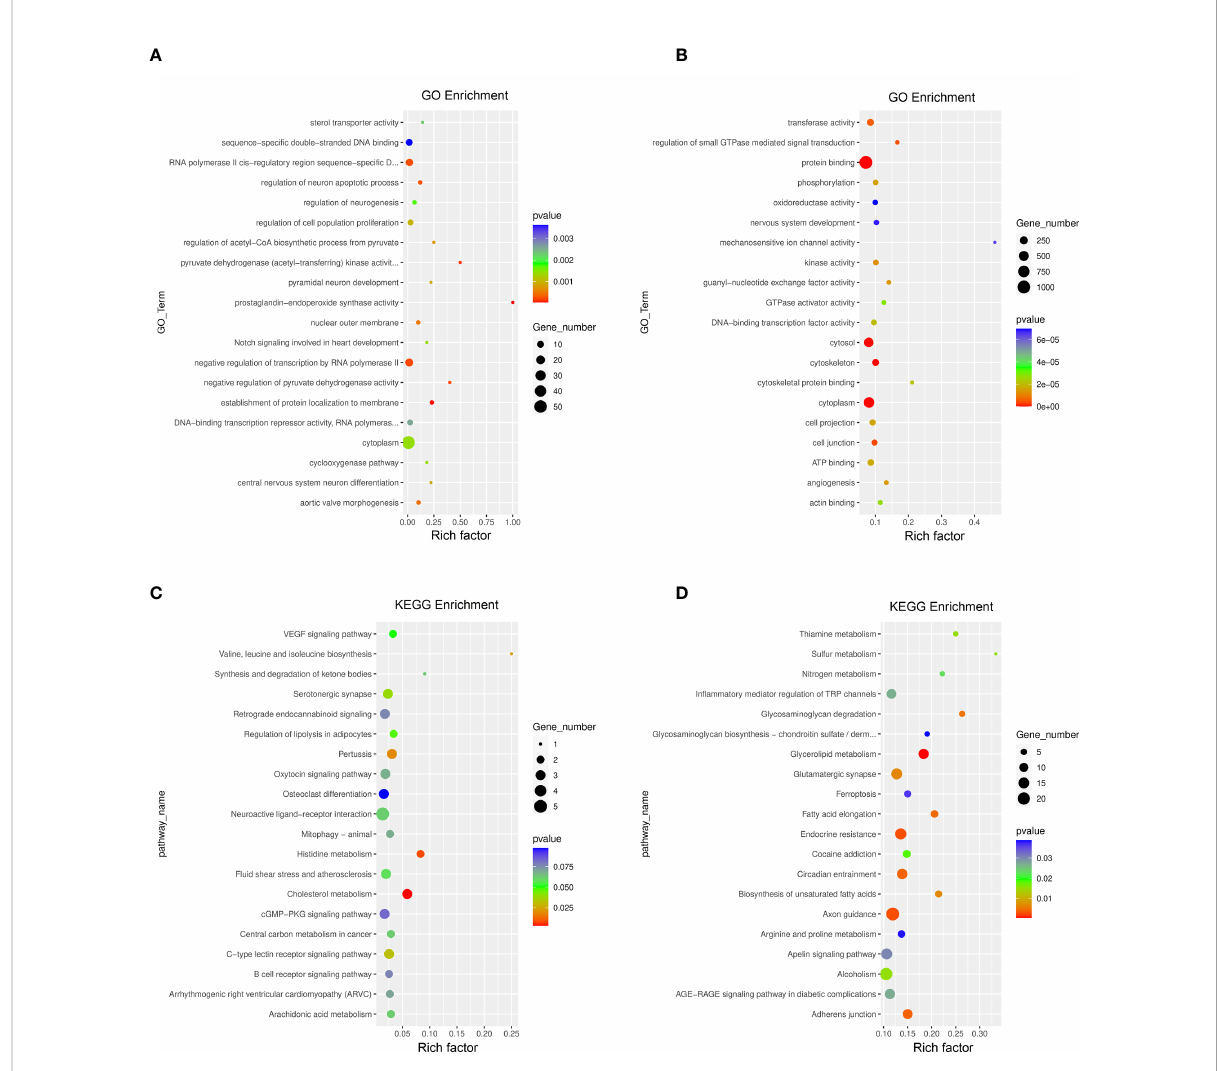
FIGURE 6 GO function and KEGG pathway enrichment of differentially expressed genes with differential m 6 A peaks. (A, B) Top 20 signi fi cantly enriched GO terms in DOK VS HOEC and SCC-9 VS HOEC cells, respectively. (C, D) Top 20 signi fi cant KEGG pathways in DOK VS HOEC and SCC-9 VS HOEC cells,